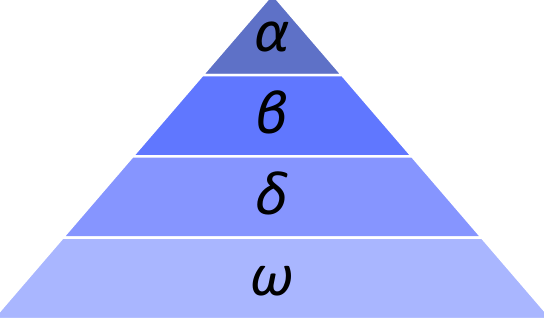
Figure 12. Grey wolves’ hierarchy (supremacy declines from top to bottom).